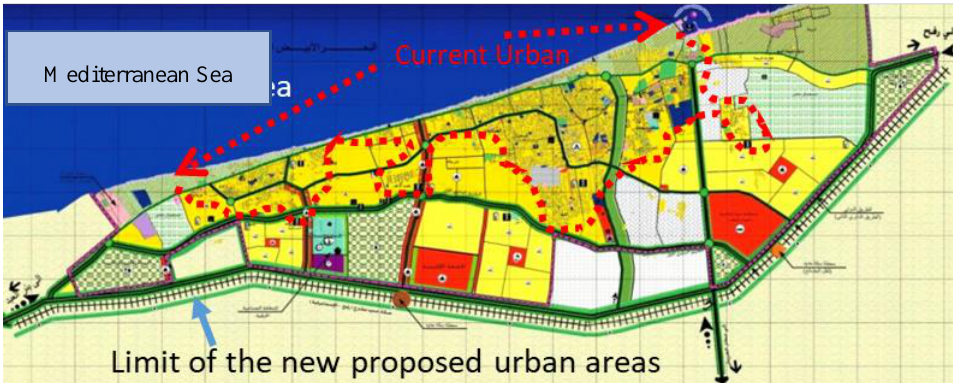
Figure 19. General strategic plan of 2027 for proposed future urbanization area for the city of Al-Arish, North Sinai-2011 [66].